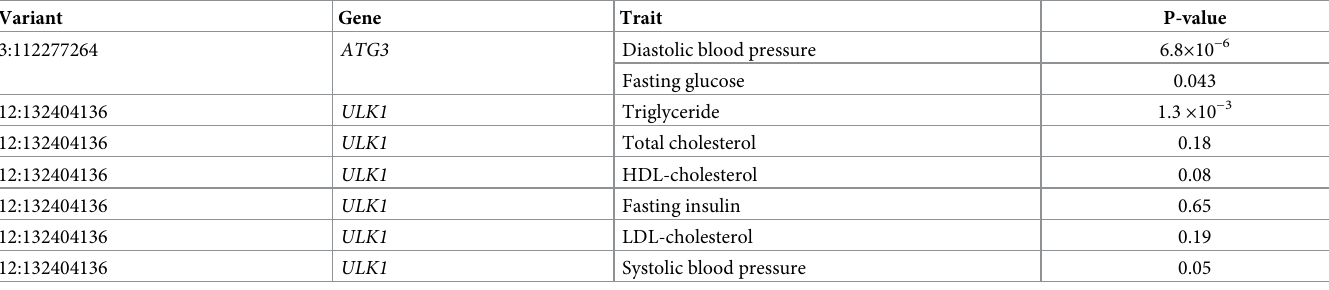
In total, 1450 individuals with a mean ± SD age of 60.6 ± 5.3 years were included in the analysis. The association of the studied CpGs and all traits and diseases are presented in S4 Table. In a fully adjusted model, we found differential methylation at ATG4B and ULK1 were associated with blood pressure (Table 5). Hypermethylation in these CpGs were associated with lower SBP/DBP. On the other hand, no significant associations between DNA methylation and gly- cemic and lipid traits were found in the study population. Using mQTLdb database, we identi- fied five trans- meQTLs associated with cg02710553. The variants were located in an intergenic region close to MAP3K7 . Furthermore, 23 trans- meQTLs associated cg06006530 were identi- fied close to CDH18 gene. meQTLs of cg02710553 were found to be associated with CAD at nominal significance level (p-value = 0.02). Table 4. LOF variants associated with intermediate vascular